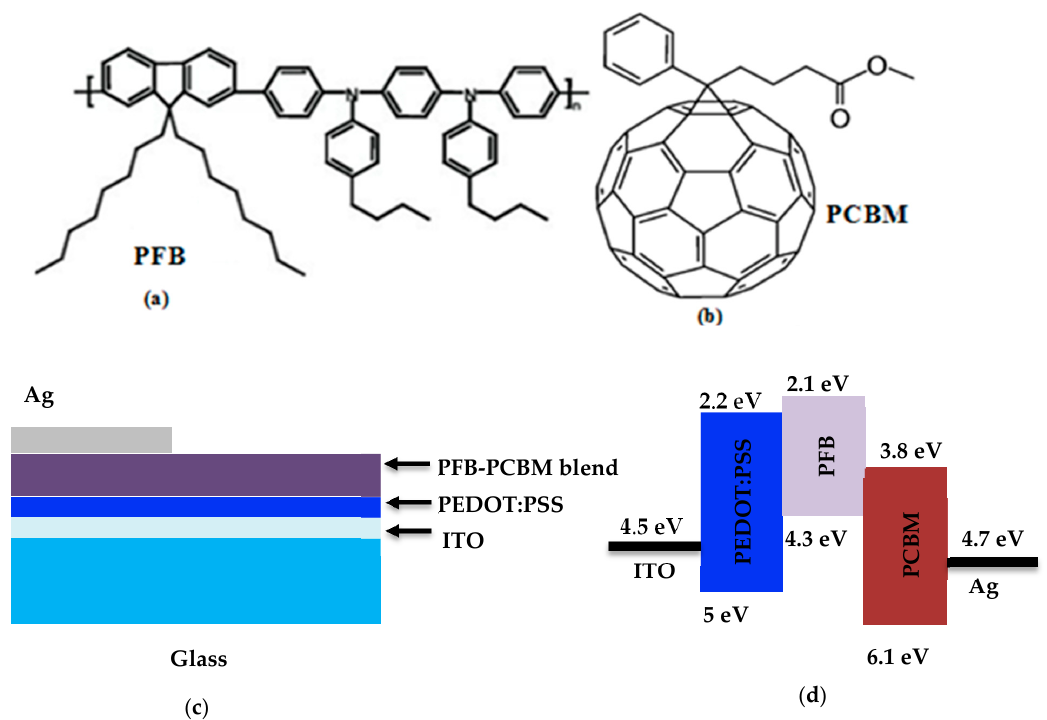
Figure1. Molecularstructures( a )poly(9,9-dioctylfluorenyl-2,7-diyl)-co-(N,N0-diphenyl)-N,Ndi(p-butyl Figure 1. Molecular structures ( a ) -oxy-pheyl)-1,4-diamino-benzene) (PFB) and ( b ) [6, 6]-Phenyl-C61-butyric acid methyl ester (PCBM); poly(9,9-dioctylfluorenyl-2,7-diyl)-co-(N,N0-diphenyl)-N,Ndi(p-butyl-oxy-pheyl)-1,4-diamino-benz ( c ) Device structure of PFB–PCBM blend based bulk heterojunction (BHJ) solar cell; ( d ) Energy levels ene) (PFB) and ( b ) [6, 6]-Phenyl-C61-butyric acid methyl ester (PCBM); ( c ) Device structure of PFB– diagram of PFB–PCBM device at equilibrium PCBM blend based bulk heterojunction (BHJ) solar cell; ( d ) Energy levels diagram of PFB–PCBM device at equilibrium unbiased.